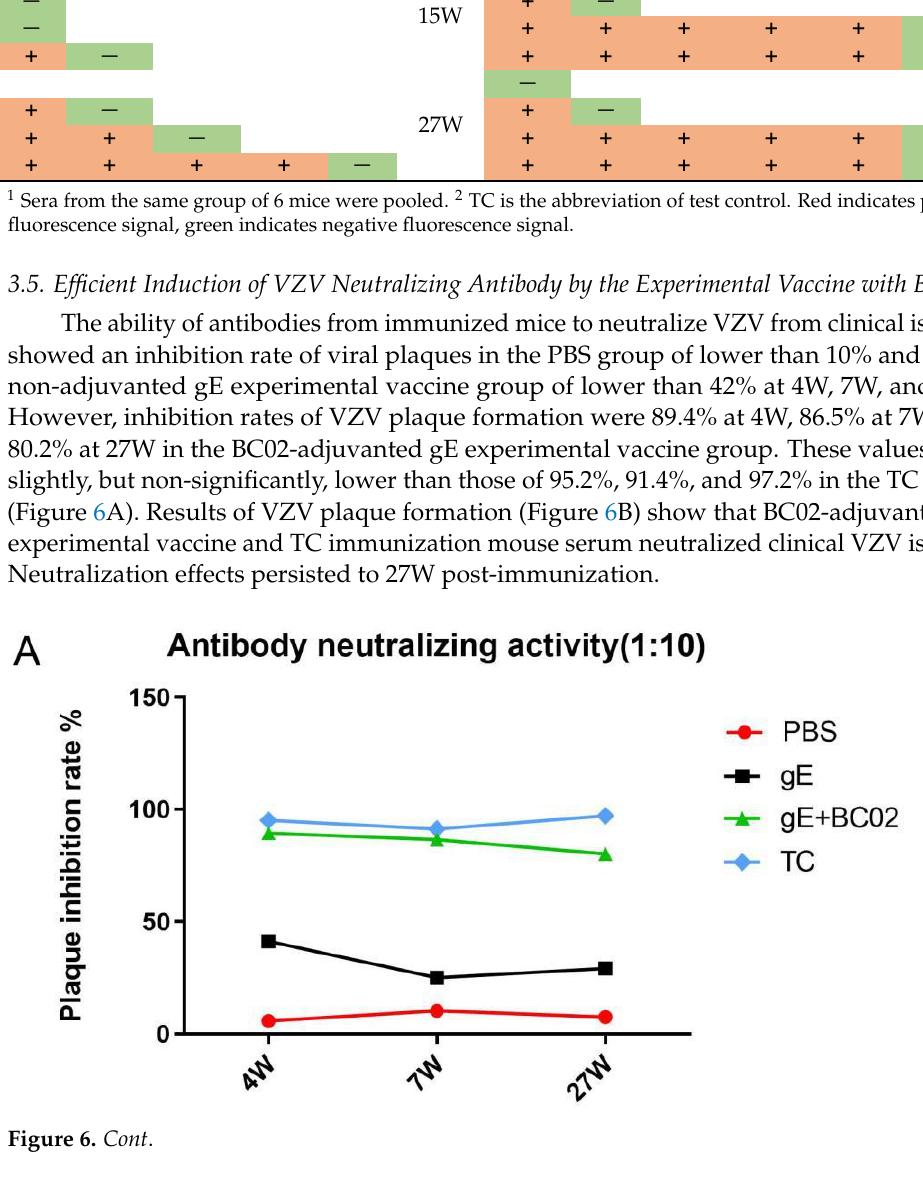
Figure 6. Inhibitory rate of VZV plaque formation by serum antibodies of immunized mice at dif- ferent time points . ( A ) The immunized mouse serum was diluted at ten-fold and changes in inhibi- tion of VZV plaque formation in different immunization groups with time were measured. ( B ) VZV plaque formation counts in different immunization groups at 4W, 7W, and 27W (Sera from 6 mice were pooled). TC is the abbreviation of test control. 4. Discussion The major viral antigens of VZV are glycoprotein components of the virion envelope, such as glycoprotein E (gE), glycoprotein B (gB), glycoprotein H (gH), and glycoprotein L (gL) [26]. The most abundant and immunogenic of these is considered to be gE (Mr 90 – 98 kDa) which is expressed on the surface of virus-infected cells and is required for neuro- virulence and cell-to-cell transmission in animal models. It has been shown that gE stim- ulates the production of neutralizing antibodies and also CMI responses and may also contain epitopes recognized by cytotoxic lymphocytes from VZV-infected patients [27 – 29]. In addition, VZV gB, VZV gH, and VZV gL are immunogenic [30,31]. The abundance of VZV gE has led to it being widely developed for use in vaccines or other related detec- tion products [32,33]. The current study expressed recombinant VZV gE glycoprotein in CHO cells and combined it with BC02 compound adjuvant (protected by independent intellectual property rights) as an experimental HZ vaccine. In immunized mice, the hy- pothesis that the novel adjuvant enhances the strength and durability of specific cellular immune responses was tested to confirm the principle of assisted vaccine protection. It is generally acknowledged that host reactivity to VZV involves both humoral and CMI responses. The VZV-specific CMI is critical for restricting reactivation and replication of latent VZV and must be considered in HZ vaccine development. Therefore, CMI is con- sidered essential in HZ prevention and in reduction of the severity and incidence of HZ- associated PHN. Clinical studies with Zostavax ® have shown that VZV-specific T-cell-me-